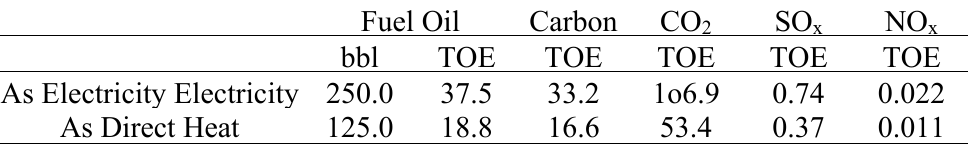
Table 4. Worldwide savings in energy, carbon and greenhouse gases using geothermal energy in terms of fuel oil (million of tonnes—TOE) including geothermal heat pump cooling